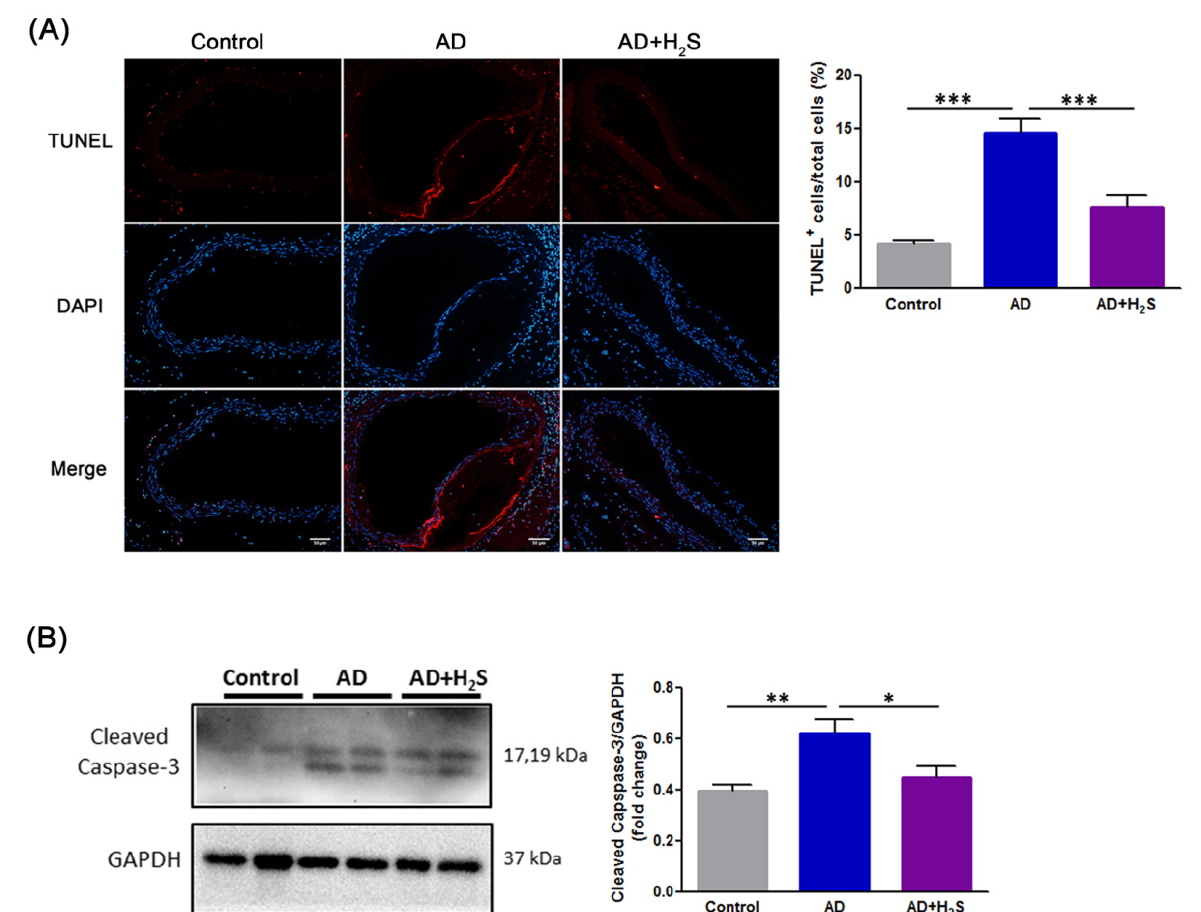
Figure 2. Treatment with H 2 S suppresses cell death in AD mice. ( A ) Representative photographs of TUNEL staining. Scale bars, 50 µ m. Apoptotic cells are shown in red and cell nuclei in blue. Quantification of TUNEL positive cells in the region of the aortas ( n = 5 per group). The data are presented as means ± SD. Statistical significance: *** p < 0.001. ( B ) Representative Western blot analysis of cleaved capspase-3 expressions in aortic tissues of each treatment group ( n = 5 per group). GAPDH was used as a loading control. Quantification of protein levels are presented as means ± SD. Statistical significance: * p < 0.05, ** p < 0.01, *** p < 0.001.